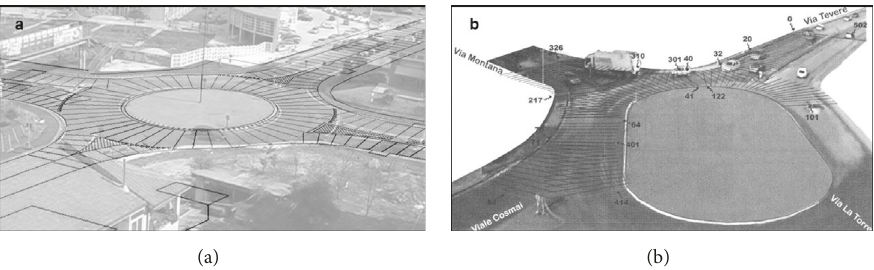
Figure 3: Position of virtual detectors used for data acquiring.